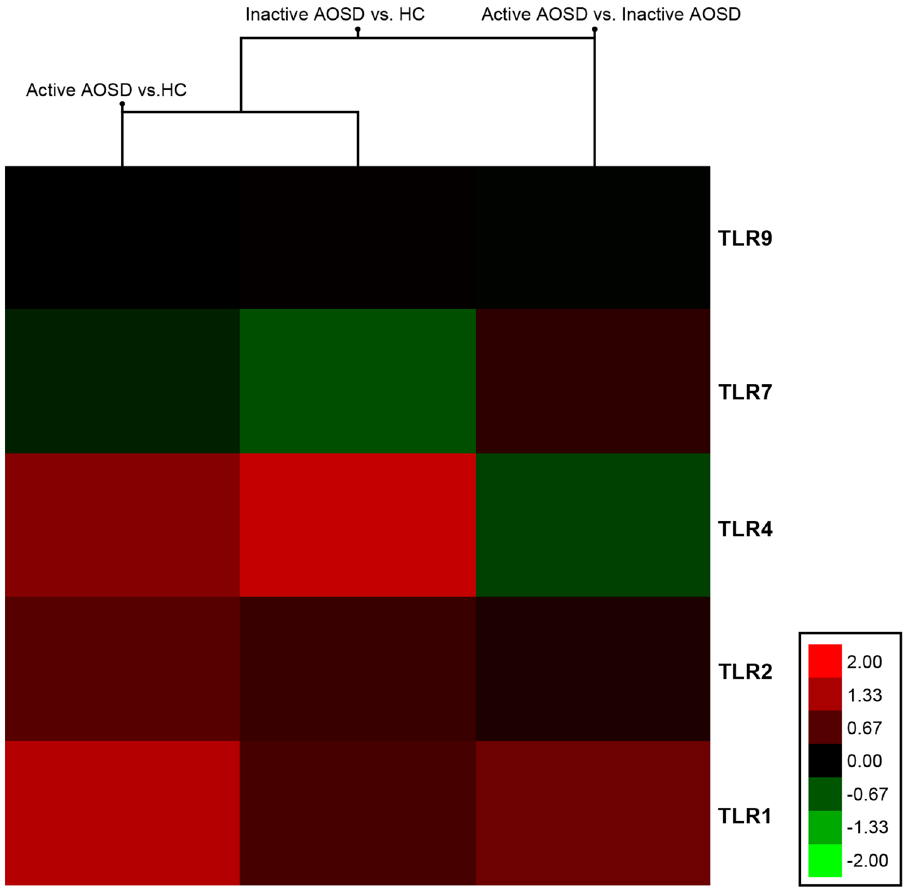
Figure 1. A heatmap of the toll-like receptor (TLR)1, TLR2, TLR4, TLR7, and TLR9 genes in peripheral blood mononuclear cells from active adult-onset Still’s disease (AOSD) relative to the healthy controls (HCs) or the inactive AOSD. The expression levels of TLR1, TLR2, and TLR4 in active AOSD or inactive AOSD were increased in comparison to those of the HC. However, the expression levels of TLR7 and TLR9 in active AOSD or inactive AOSD were not different to those of the HC. The expression levels of TLR1 and TLR7 in active AOSD were increased than those of inactive